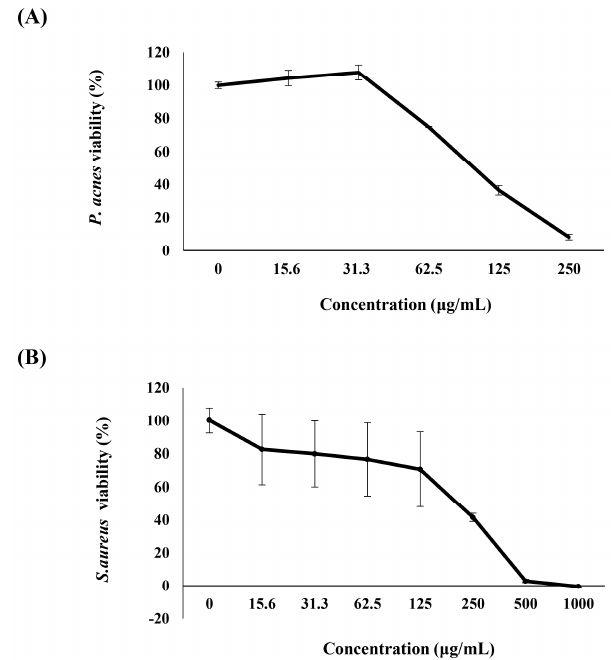
Figure 1. Antimicrobial effect of Kaempferia parviflora extract against ( A ) Propionibacterium acnes and ( B ) Staphylococcus aureus . All data are presented as the mean ± standard deviation (SD) of three independent experiments.